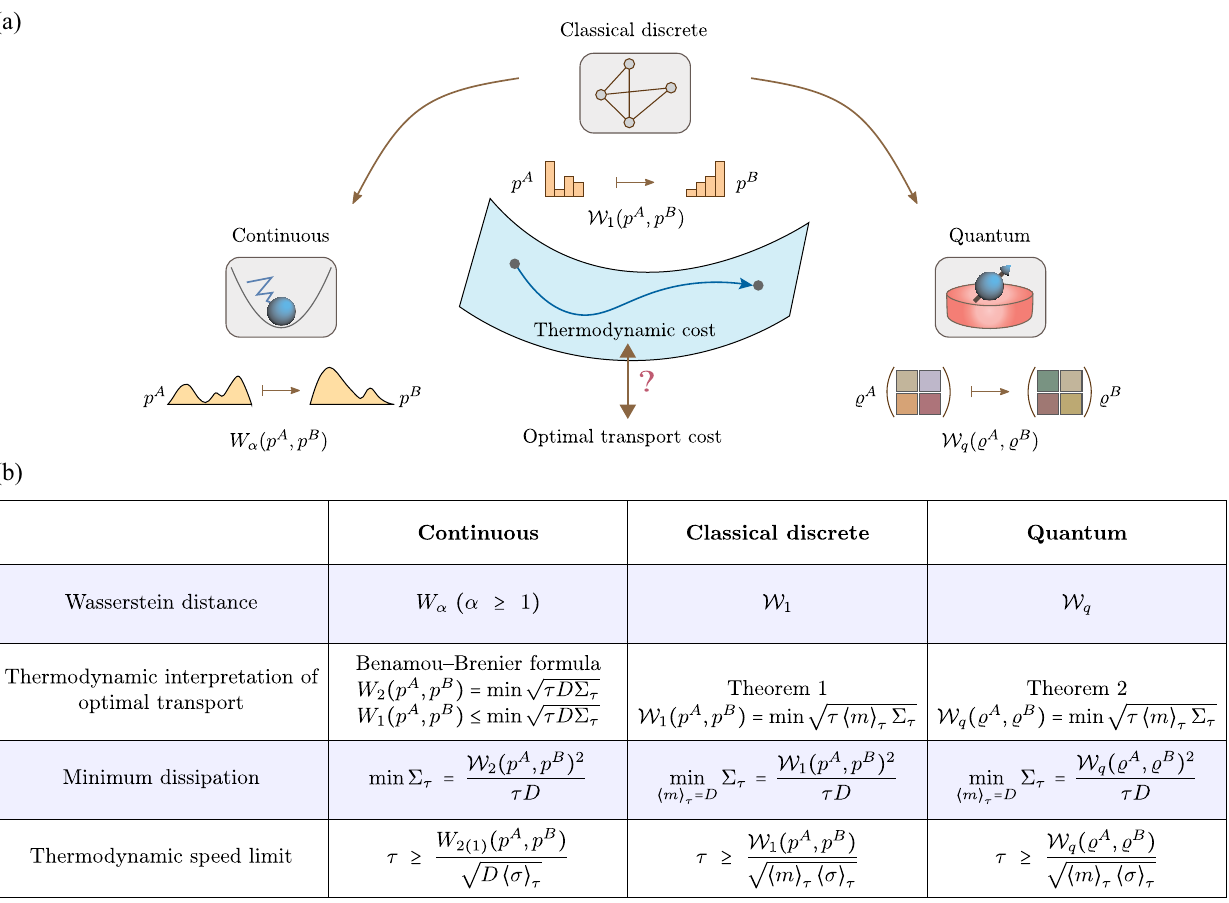
FIG. 1. (a) Schematic of stochastic and quantum thermodynamics of discrete Markovian dynamics and the optimal transport problem. This study aims to reveal the connection between thermodynamics and the optimal transport theory for discrete cases, including both classical and quantum systems. (b) Our thermodynamic unification of optimal transport and its consequences, including minimum dissipation and thermodynamic speed limits. By introducing dynamical state mobility m , we provide a unified, discrete generalization t of the Benamou-Brenier formula for classical and quantum discrete systems. See Sec. I B for an